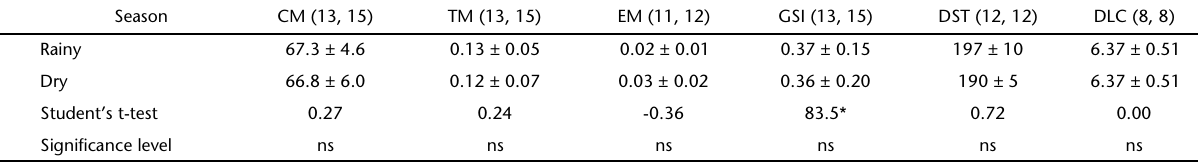
Table 1. Mean values (± 1 Standard Deviation) of corporal mass (CM, g), testis mass (TM, g), epididymis mass (EM, g), gonadosomatic index (GSI), diameter of the seminiferous tubules (DST, µm) and diameter of the Leydig cell nucleus (DLC, µm) of the large fruit-eating bat in rainy and dry seasons (respective sample sizes in parenthesis) of December 2001 to January